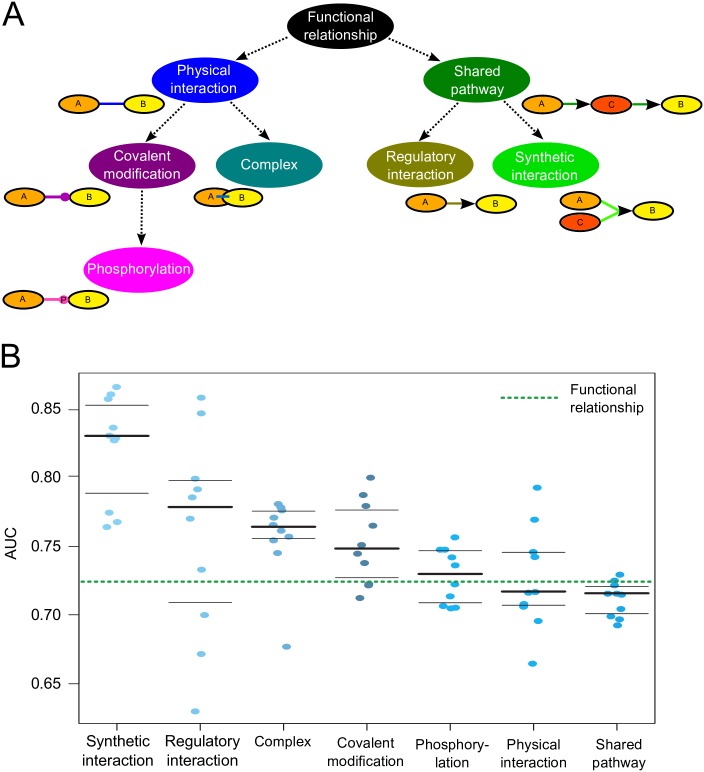
Mechanistic interaction networks specific to prostate cancer and the NFκB pathway.(A) We constructed an interaction ontology containing seven interaction types: a functional relationship can be a physical interaction (two genes directly bind to each other and interact physically), a complex (two genes form a protein binding complex), a covalent modification (a kinase posttranslationally modifies a substrate), a phosphorylation (a kinase adds a phosphate group to a substrate at a phosphorylation site), a shared pathway (two genes react in the same pathway which can be an indirect regulation), a regulatory interaction (a gene is activating or inhibiting another gene), or a synthetic interaction (two genes simultaneously regulate another gene, whereas the two genes individually would not regulate the third gene). (B) The performance (AUC values) of the seven trained mechanistic interaction networks after performing a 10-fold gene-holdout-based cross-validation of each of the networks revealed that the mechanistic interaction networks are generally more accurate than the global functional network.